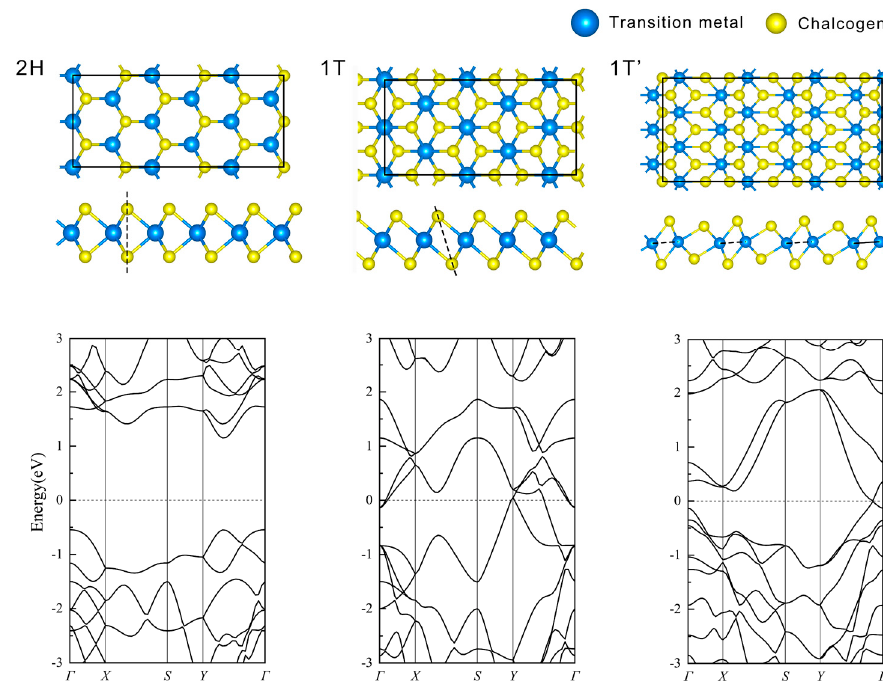
Figure 1. Monolayer atomic structure and band structure of TMDs in 2H, 1T, and 1T’ phases.